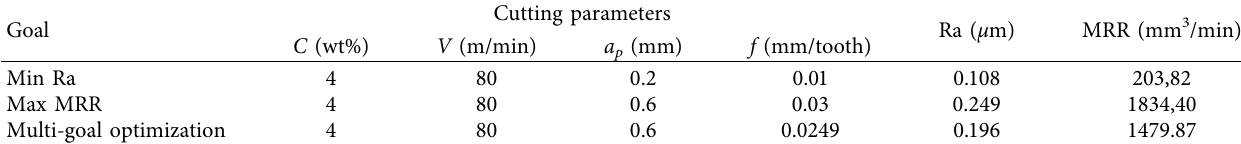
Table 6: Results of RA and MRR with different cutting